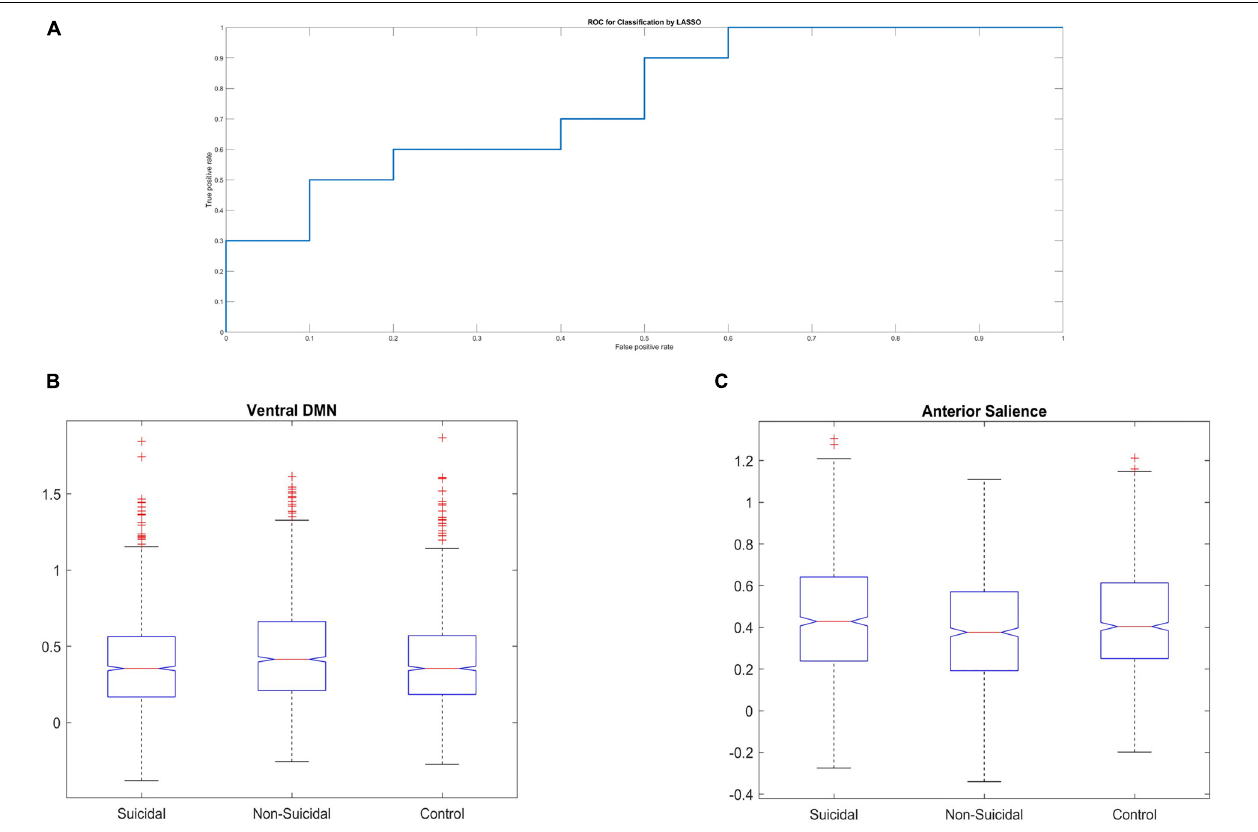
FIGURE 3 | (A) Receiver operating characteristic curve for LASSO classificator applied to Functional Connectivity with Power 264 atlas. (B) Box-and-whisker plot illustrating the differences between three groups in Functional Connectivity among ventral Default Mode Network. (C) Box-and-whisker plot illustrating the differences between three groups in Functional Connectivity among Anterior Salience Network. The outliers can be seen due to the high variance of dFC values.